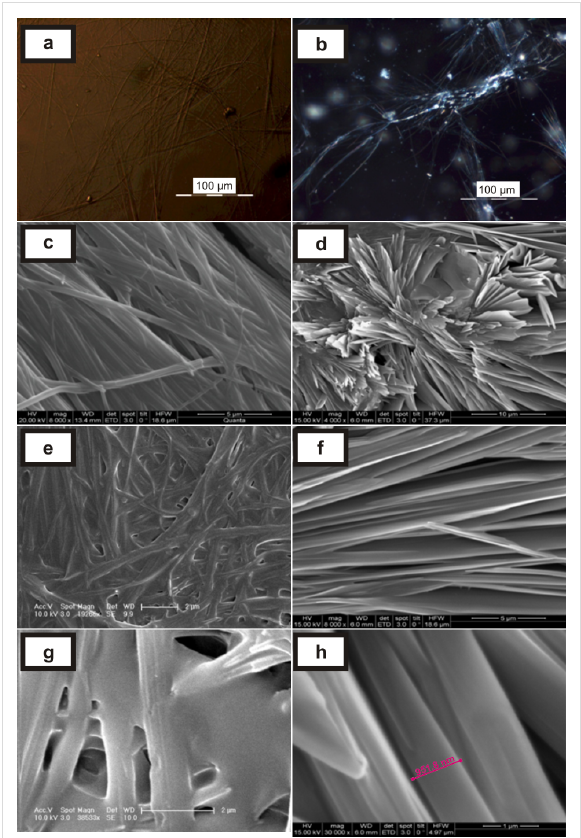
Figure 5: (a) and (b) POM images of bis(2-hydroxyethyl)aminodeoxy- cholane 2 gel in 1:1 DMSO/water (normally-cooled gel); (c), (e) and (g) SEM images of the xerogels (normally cooled gels); (d), (f) and (h) SEM images of the xerogels (heated and sonicated).